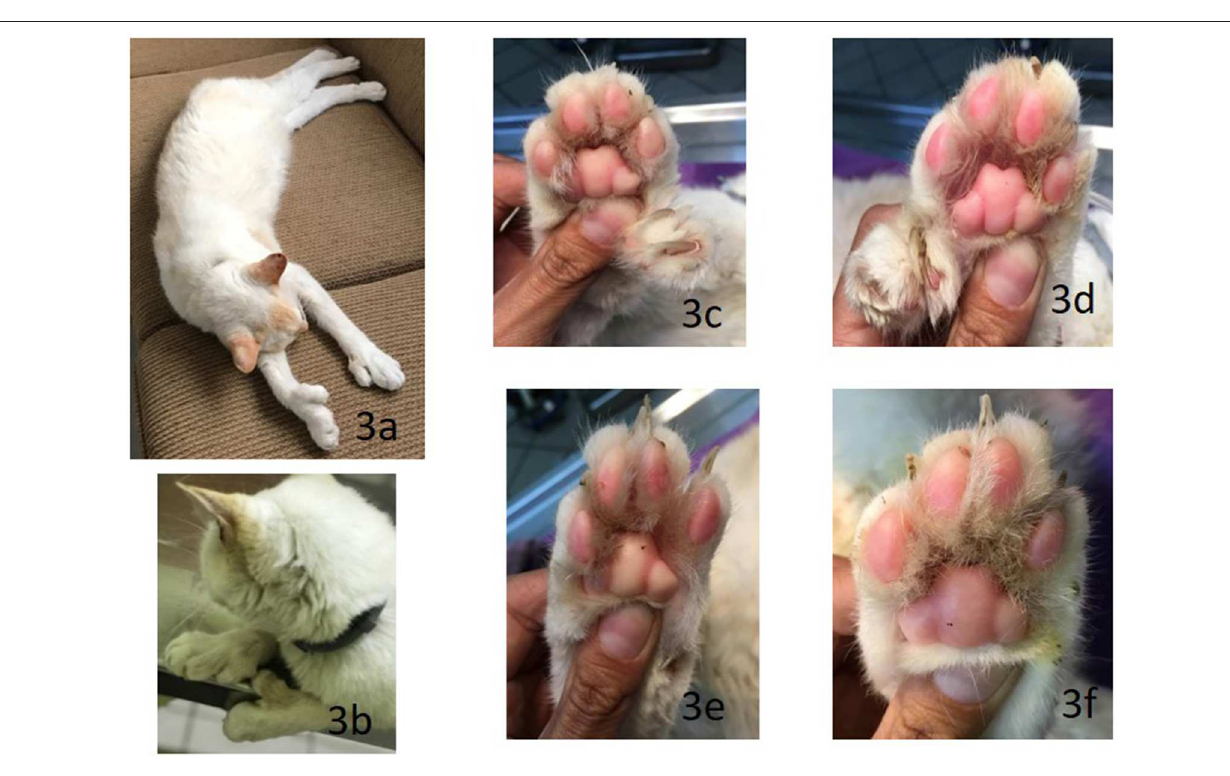
a pre-cleaned microscope slide, fixed, and then stained